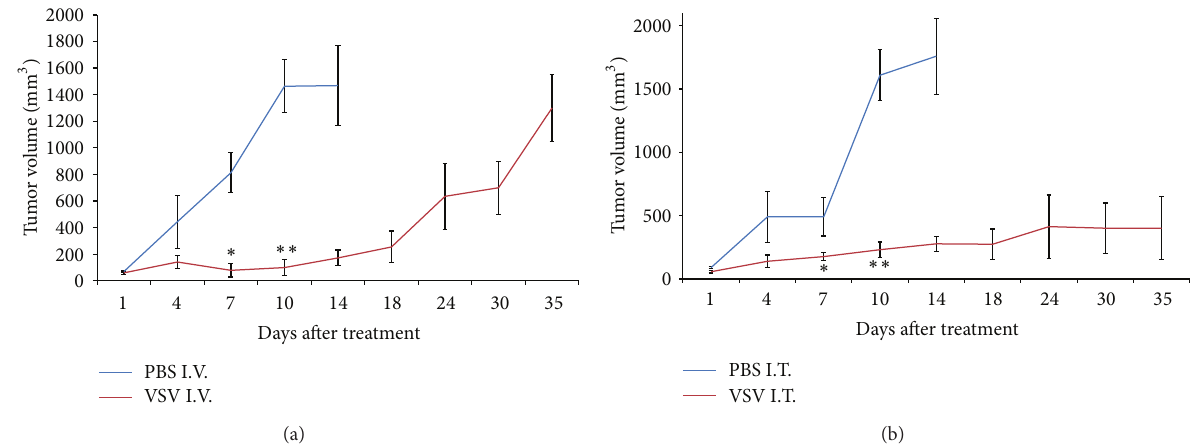
Figure 7: VSV Δ M51 treatment significantly reduces tumor growth after local and systemic administration. (a)-(b) A single VSV Δ M51 injection was administered either intravenously (I.V.) (a) or intratumoral (I.T.) (b). Tumor size was monitored over a period of time. Mice were sacrificed based on a preset tumor volume decided upon with animal care. Error bars represent standard error of the mean ∗ 𝑃 < 0.05 , ∗∗ 𝑃 < 0.005 (Student’s t -test). 𝑁 = 4 mice per group. Note VSV in legend represents VSV Δ M51.